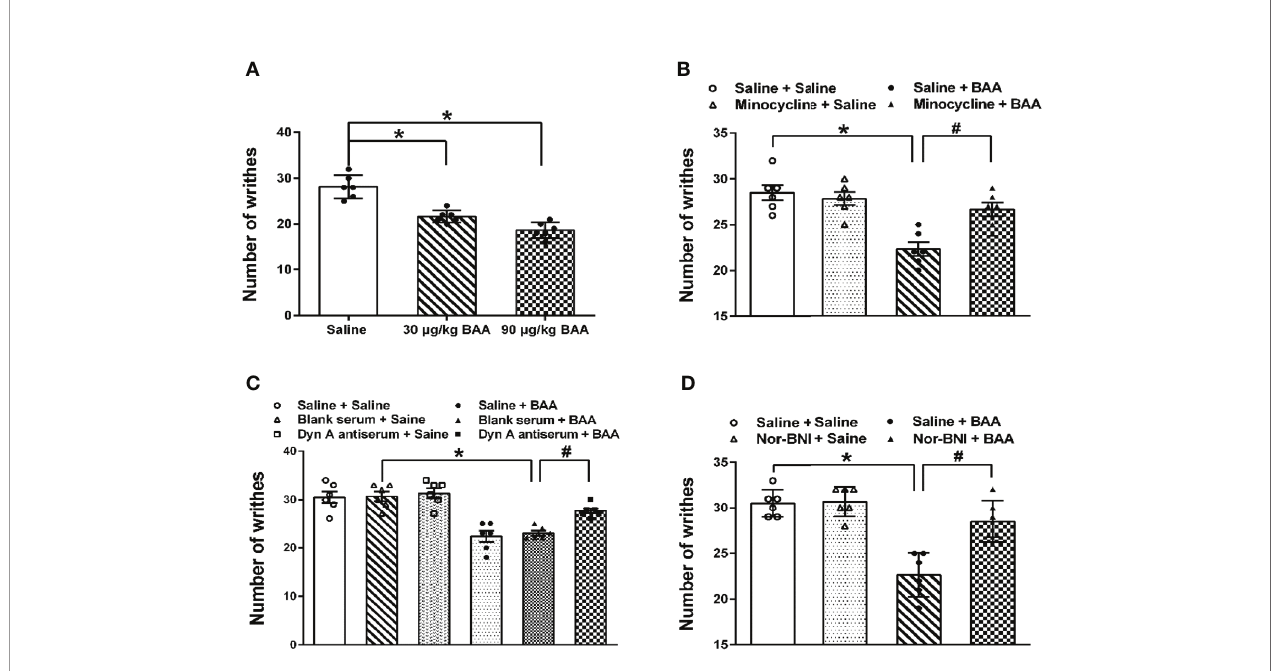
FIGURE 1 | The antivisceral pain effect and the mechanism of Bulleyaconitine A (BAA). (A) BAA signi fi cantly produced antivisceral pain effect (n = 6 each; one-way ANOVA; * P < 0.05. (B) Minocycline blocked the effect of BAA on acute visceral pain in rats (n = 6 each; one-way ANOVA; * P < 0.05; # P < 0.05). (C) Intrathecal injection of dynorphin A antiserum inhibited the effect of BAA on acute visceral pain in rats (n=6 each; one-way ANOVA; * P < 0.05; # P < 0.05). (D) Nor-binaltorphimine dihydrochloride (Nor-BNI) blocked the effect of BAA on acute visceral pain in rats (n = 6 each; one-way ANOVA; * P < 0.05; # P < 0.05). The data are presented as means ± standard error of means